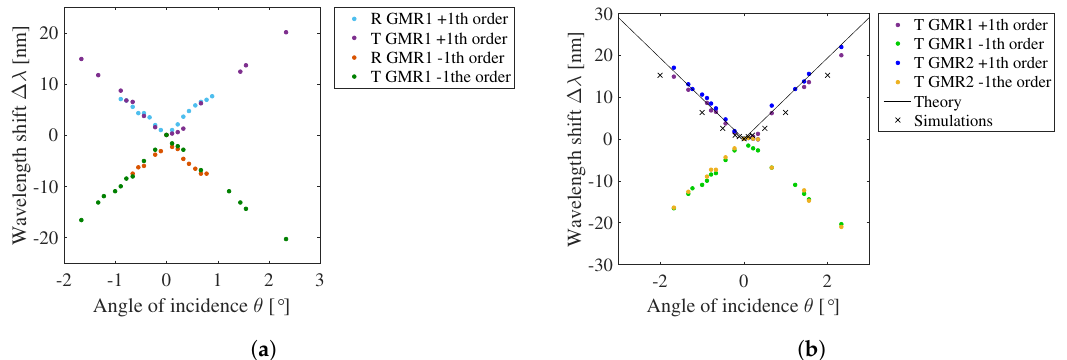
Figure 29. The measured shift of the resonant wavelength ∆ λ with the angle of incidence θ . ( a ) Reflection and transmission measurement for one grating. ( b ) Transmission measurement for two gratings with a different pitch.